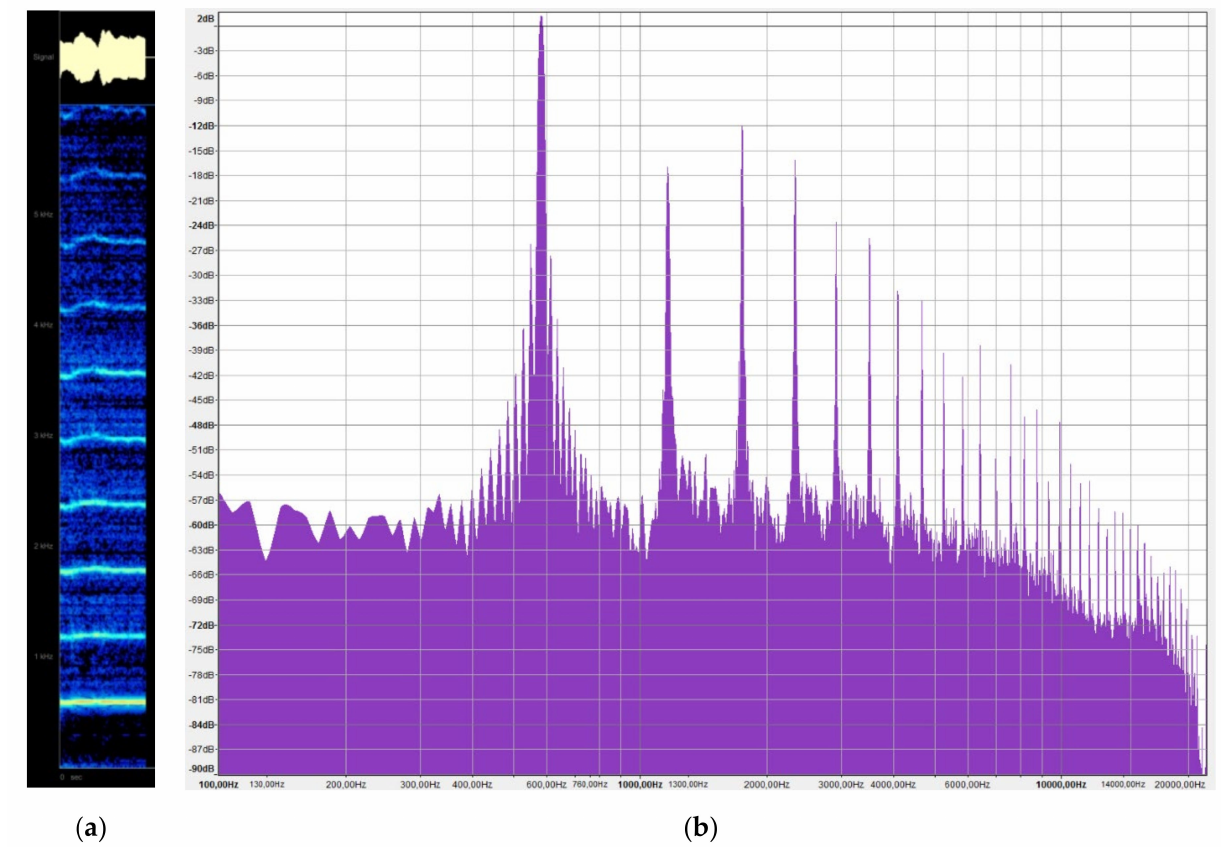
Figure 12. Spectral components of shell horn made from Aliger gigas . Experimental model, low blowing pressure: ( a ) spec- trogram; ( b ) spectrum (Sample